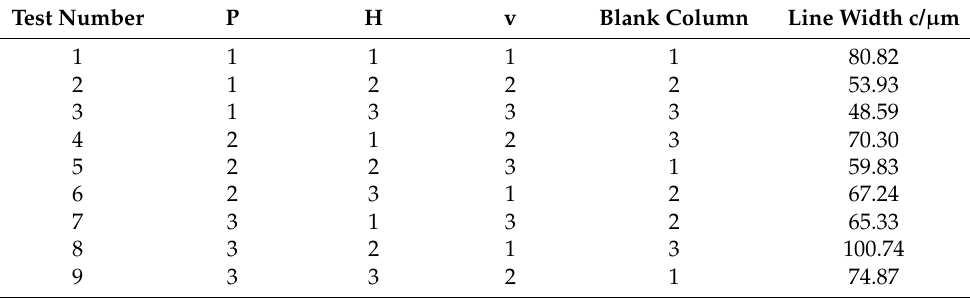
Table 4. Three-factor and three-level orthogonal experimental design and experimental results. Test